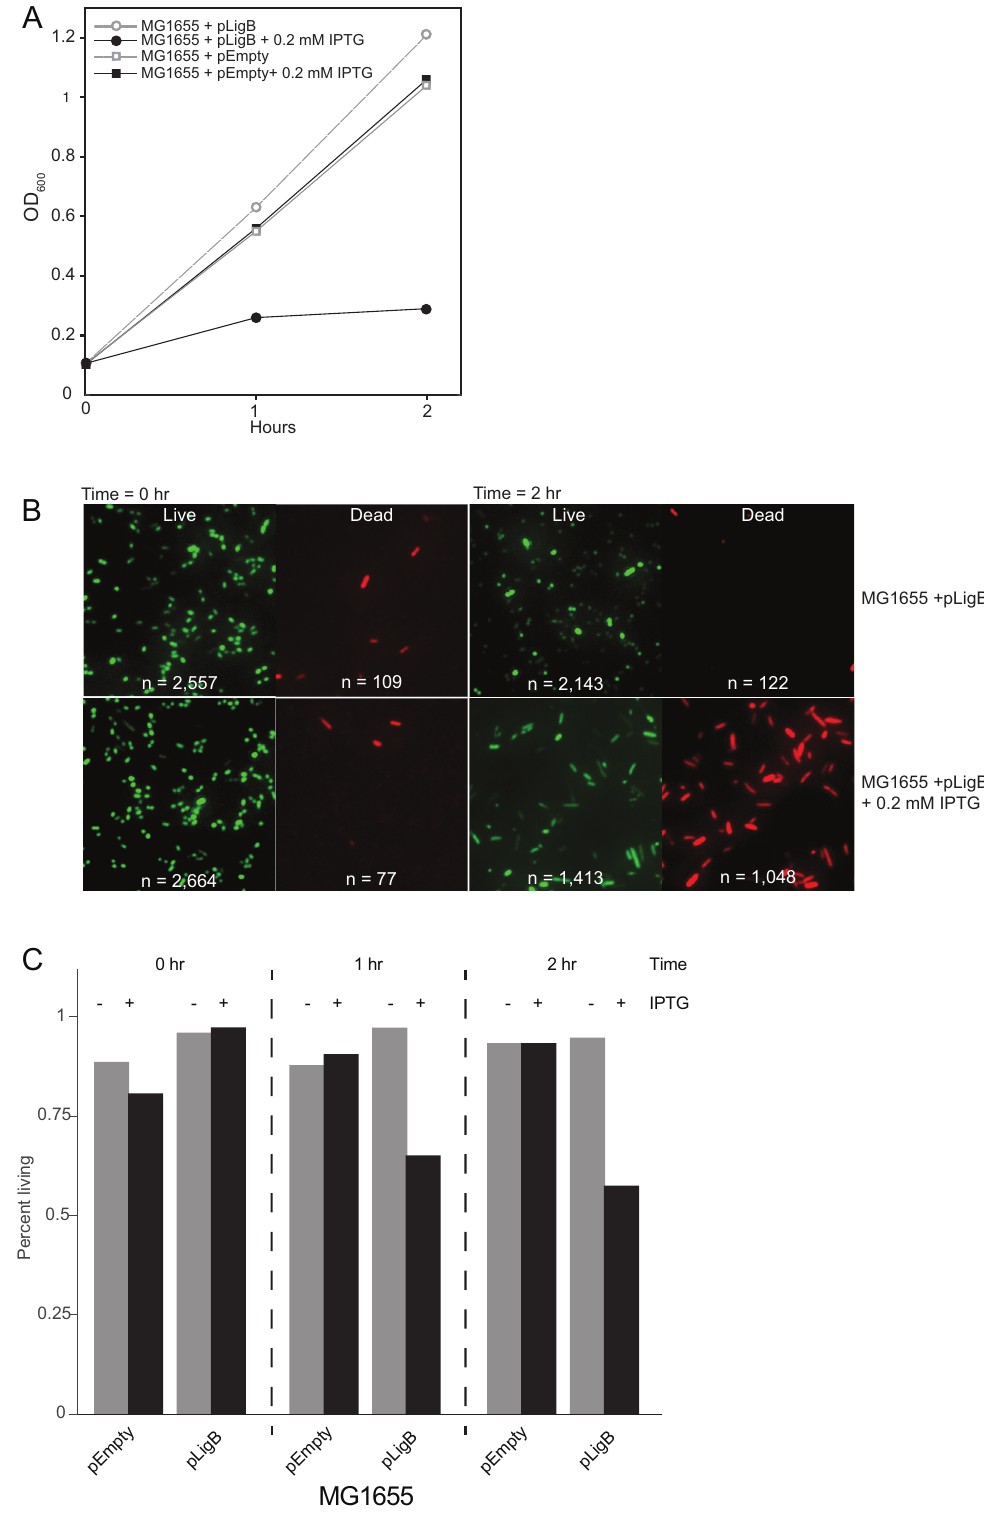
Fig 5. Effect of lig B overexpression during logarithmic phase. E . coli MG1655 with plasmid pLigB or pEmpty were grown overnight, diluted into fresh growth medium, grown to OD 600 = ~0.1, and inducedwith 0.2 mM